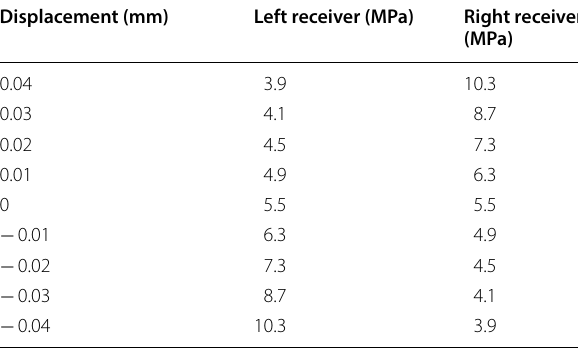
Table 5 Receiver pressures after modification